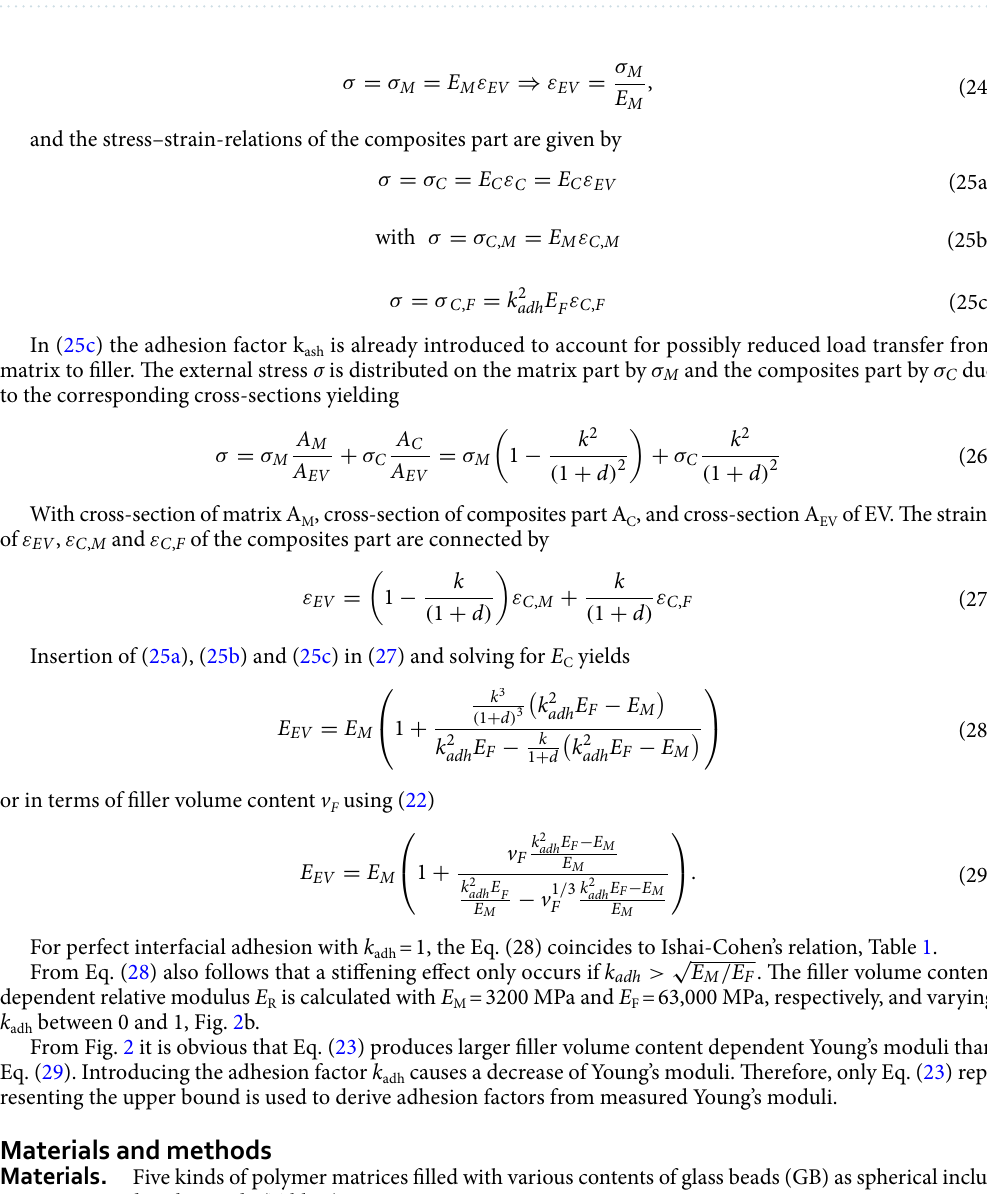
Table 2. Properties of matrices and dispersed phase